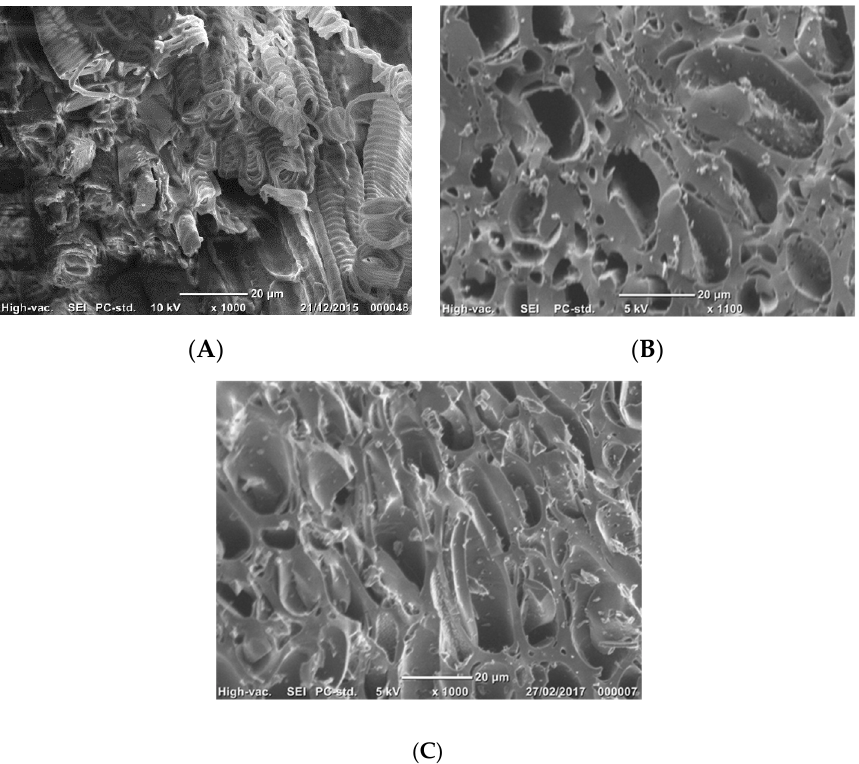
Figure 5. SEM for raw macadamia nut shell ( A ) and pyrolyzed at 900 °C ( B ) and 1000 °C ( C ).